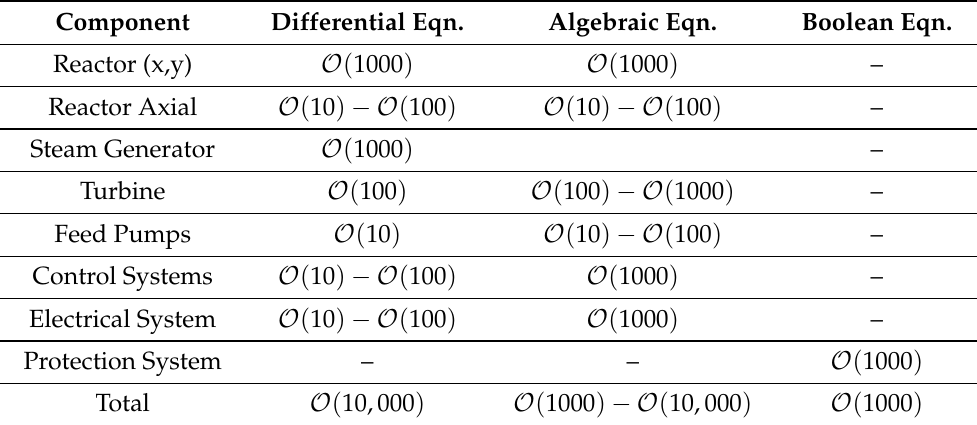
Table 1. Number of unknowns by type of equation for a real-time, full-scope plant simulator. The O -notation indicates order of magnitude. For example, “ O ( 1000 ) ” in the second row, second column means the “Reactor (x,y)” equations need to solve thousands of unknowns from the discretized differential